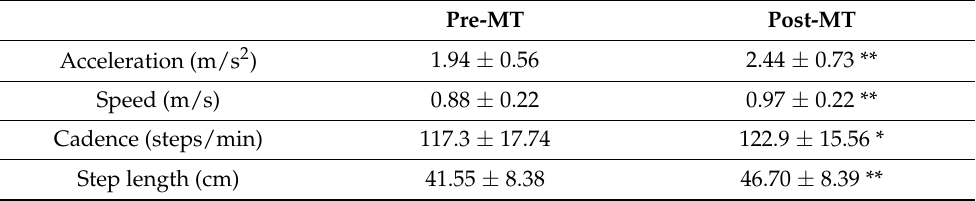
Table 1. Comparison of gait characteristics before and after music therapy